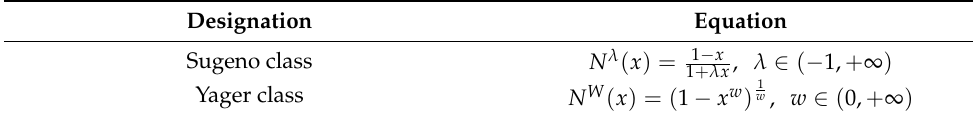
Table 2. Basic fuzzy negations